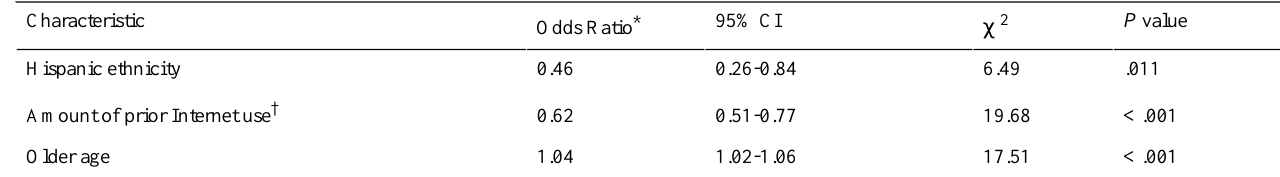
Table 2. Pretest characteristics significantly associated with responding to the email messages in final multivariate